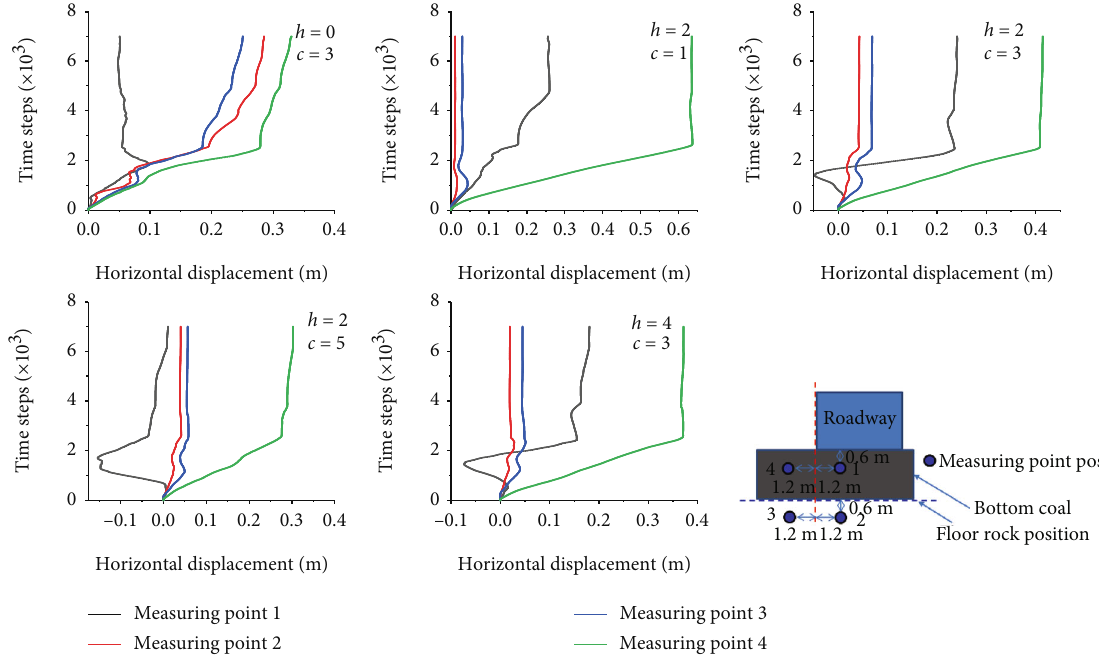
Figure 15: Curve of measuring point moving along the horizontal direction in the roadway fl